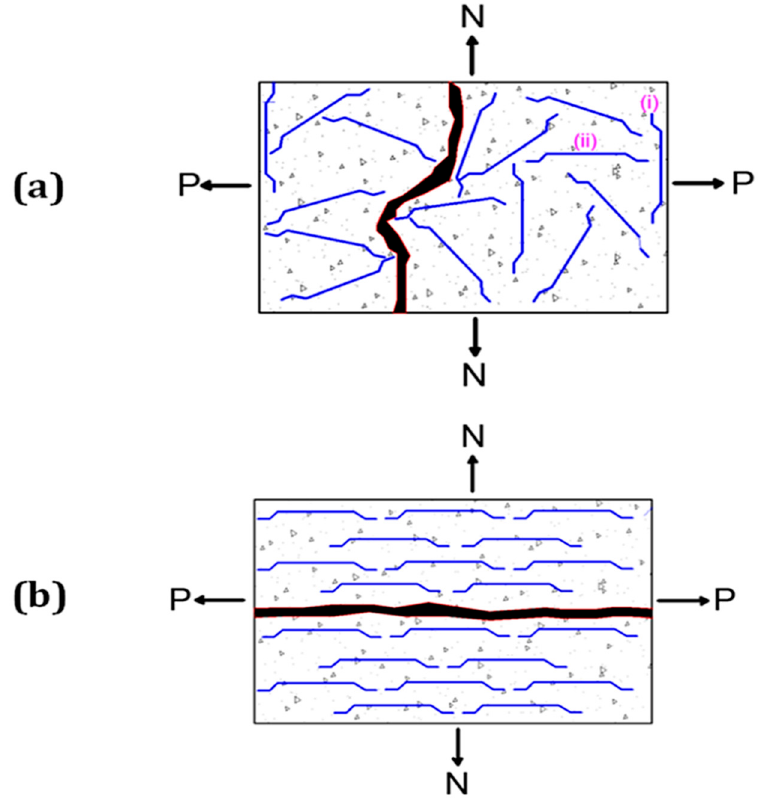
Figure 3. The arrangement of fibres in the matrix: ( a ) random three-dimensional fibre distribution with optimum orientations (i) and (ii); and ( b ) unidirectional distribution [40].